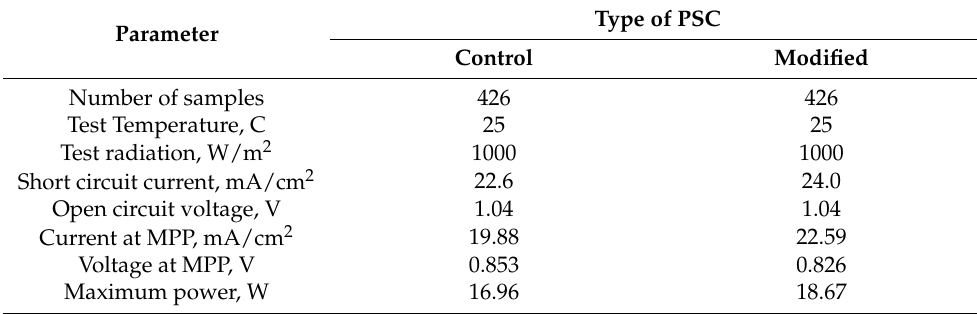
Table 1. General data related to control and modified PSCs.